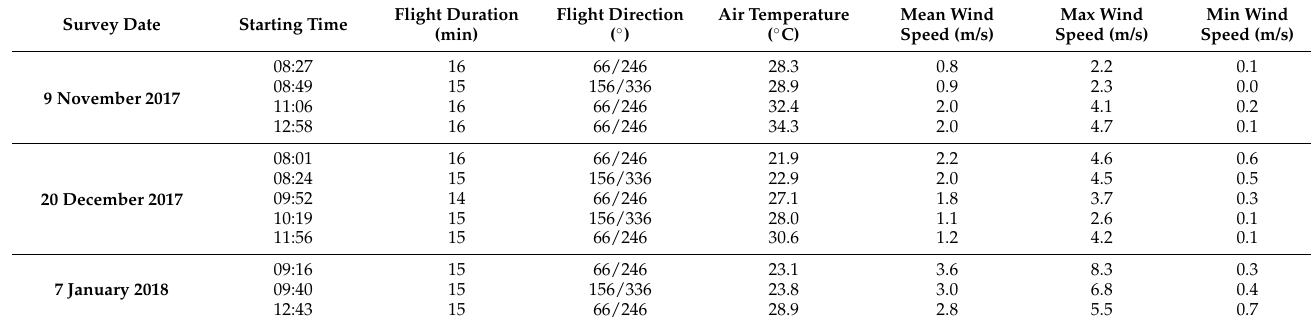
Table 1. Flight times and meteorological conditions, including air temperature and mean, maximum (max) and minimum (min) wind speed, recorded during each UAV flight survey on 9 November 2017, 20 December 2017 and 7 January